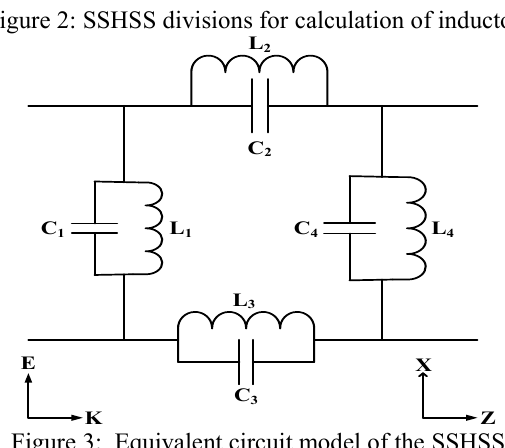
Figure 3: Equivalent circuit model of the